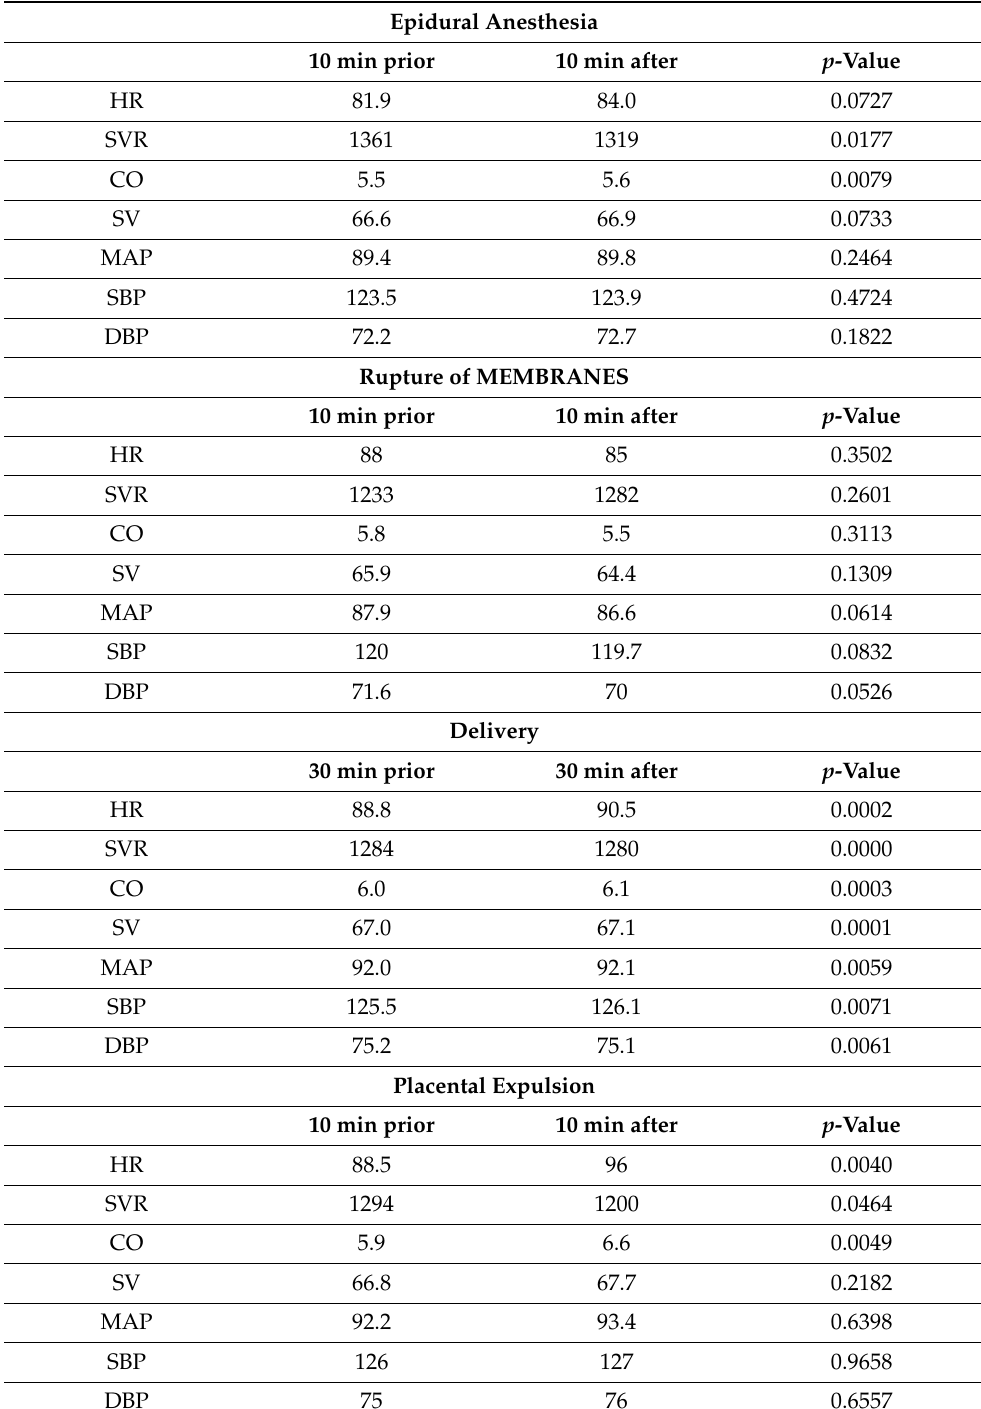
Table 2. Trends in vital signs during labor and